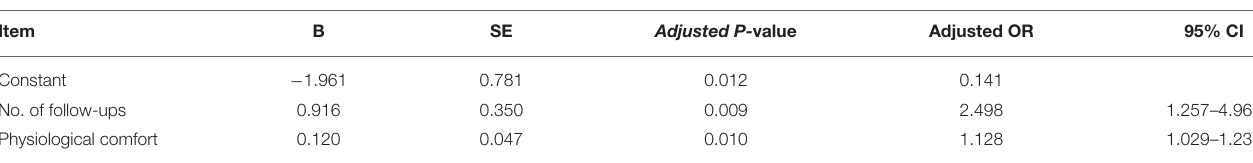
TABLE 3 | Multivariate logistic regression analysis of patient